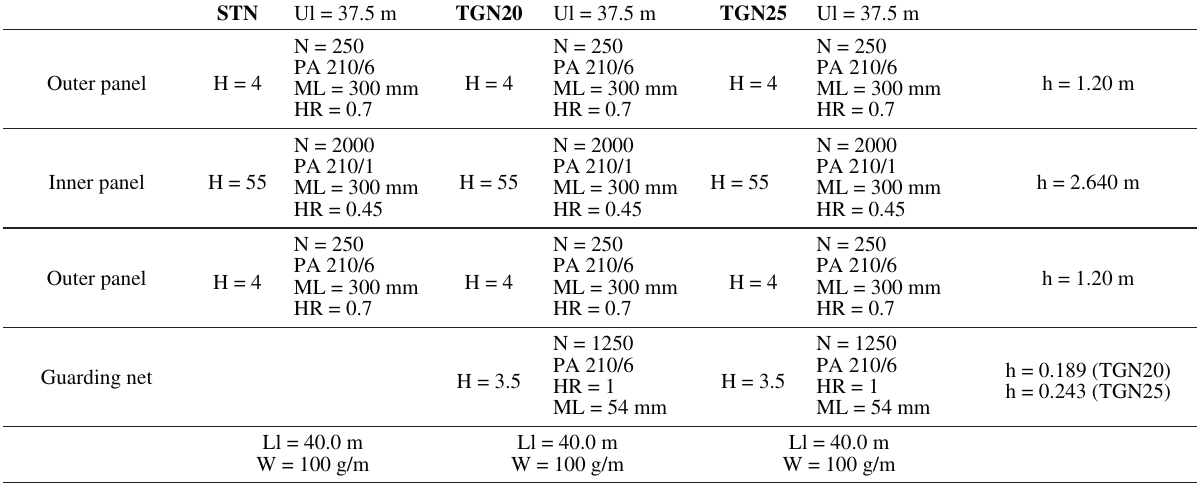
Table 1. – Technical features of the gears used for the sampling. STN, Standard Trammel Net; TGN20, standard trammel net provided with a guarding net of 19 mm; TGN25, standard trammel net provided with a guarding net of 24 mm; H, number of meshes (height); N, number of meshes (width); HR, hanging ratio; PA, polyamide; 210/x, nominal titre in deniers; MT, stretched mesh length; h, sheet height; Ul, upper length of panel; Ll, lower length of panel; W, weight of the lead line. For each net a single sheet of the inner and the outer panels is